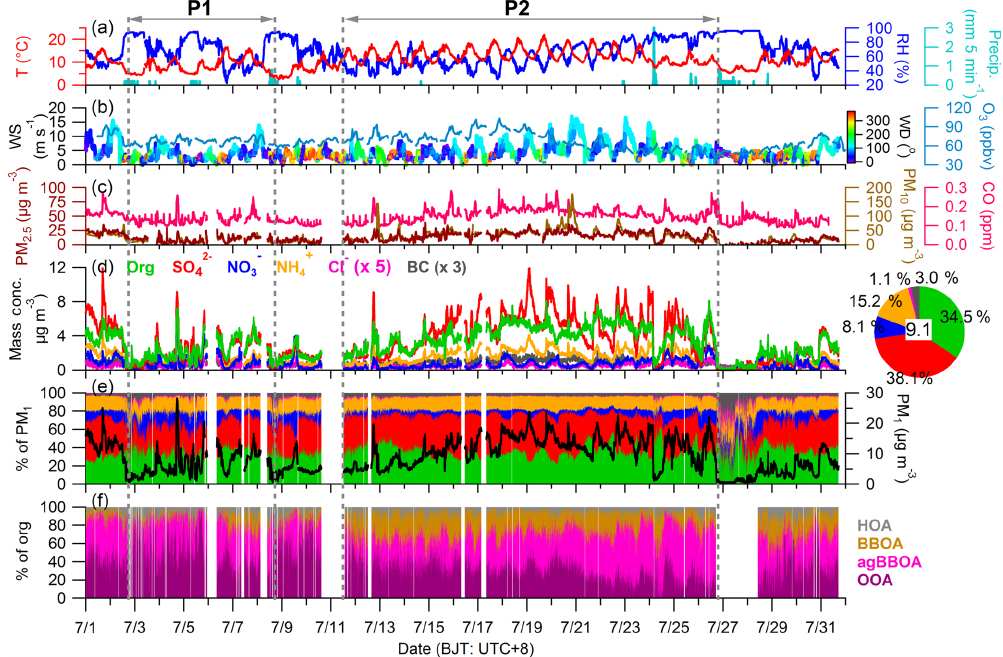
Figure 2. Time series of (a) ambient temperature ( T ), relative humidity (RH) and precipitation (Precip.); (b) wind speed (WS) colored by wind direction (WD) and O 3 ; (c) mass concentrations of PM 2 . 5 , PM 10 and CO; (d) mass concentrations of PM 1 species; (e) mass contributions of PM 1 species as well as the total PM 1 mass concentrations; and (f) mass contributions of four organic components. The pie chart shows the average chemical composition of PM 1 for the entire study period, with the average PM 1 mass concentration (unit of µgm − 3 ) marked in the center.